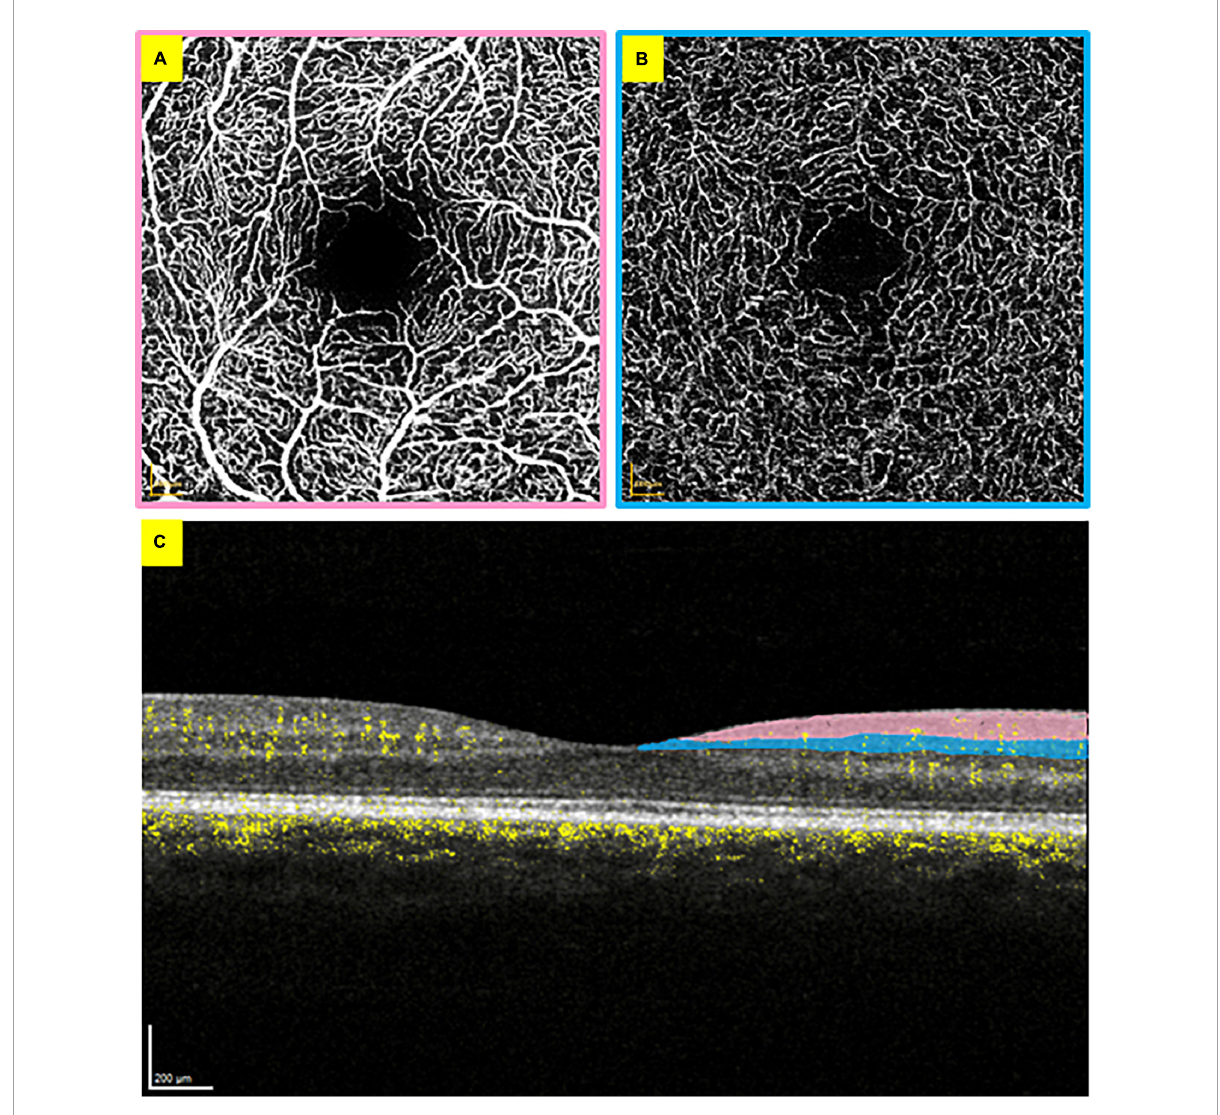
FIGURE1 Optical coherence tomography angiography scans from the right eye. (A) En face superficial vascular plexus layer with the foveal avascular zone visible in the centre. (B) En face intermediate capillary plexus layer. (C) Cross-section of the retina, with blood flow visible in yellow. The added colour areas correspond to the borders of panels (A,B) to demonstrate the vascular bed